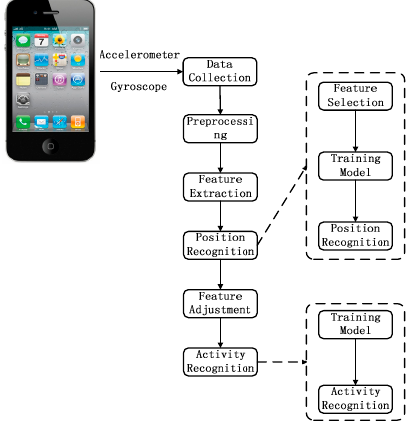
Figure 1. Flowchart of the proposed Parameters Adjustment Corresponding to smartphone Position (PACP) activity recognition method.